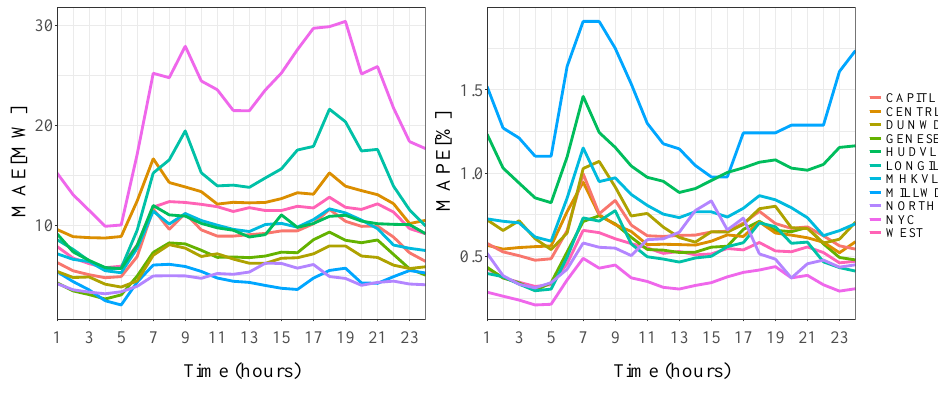
Figure 8. Hourly MAE/MAPE results for NYISO zones for